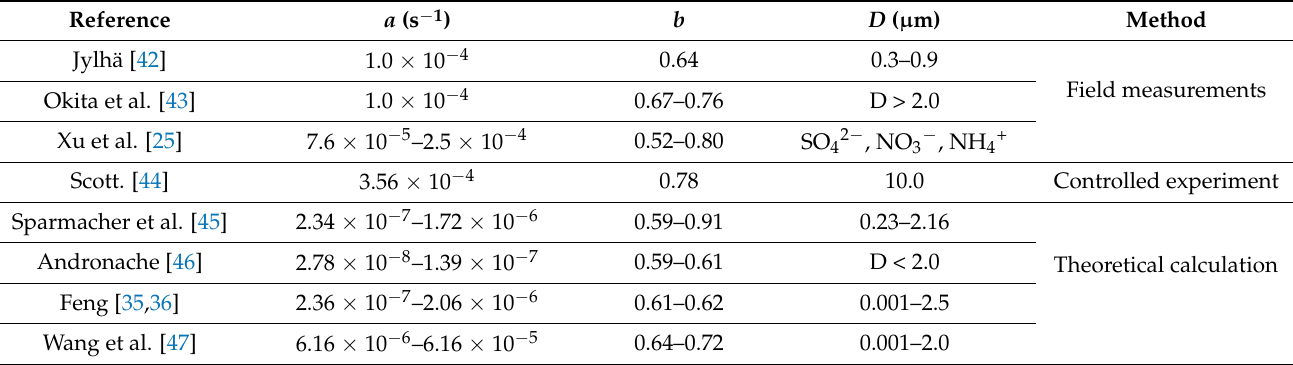
Figure 6. Scatter plots between the washout contribution of SO 42 − (solid black line and dots), NH 4+ (solid green line and dots), and NO 3 − (solid red line and dots) from the total wet deposition flux and the a parameter in WSC = aP b . The solid lines are regression lines of the linear least-squares fitting. Table 6. Wet scavenging coefficient (WSC) values investigated in previous studies on WSC = aP b by particle size ( D ) and method.